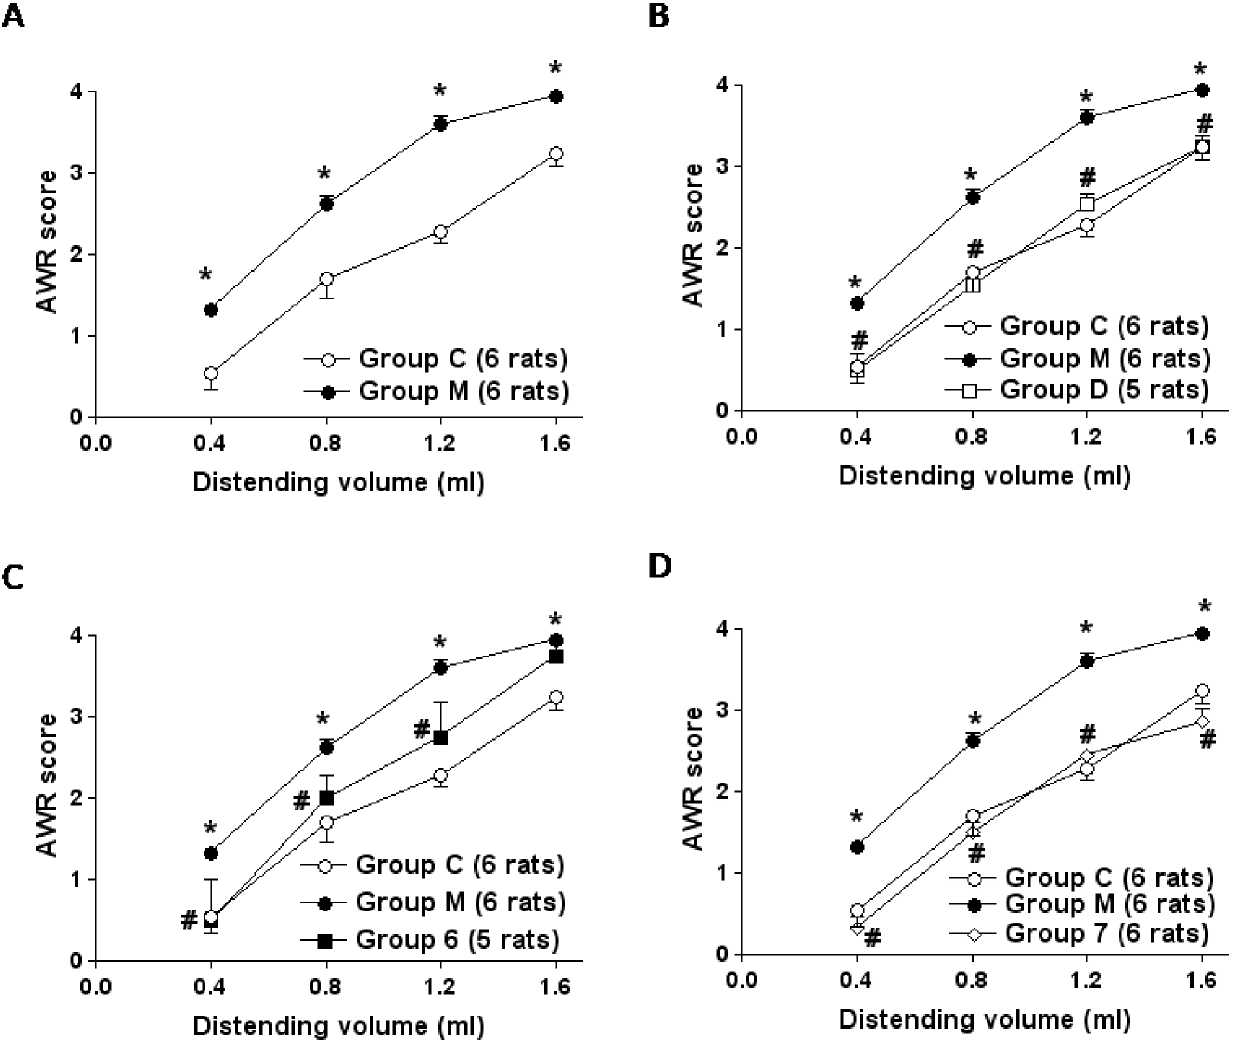
Figure 1. VSL # 3 reverses hypersensitivity induced by NMS. (A) Group C and Group M are the same in all comparison experiments. In healthy animals (Group C, 6 rats) CRD (0.4–1.6 ml water) elicited a volume-dependent increase of the AWR scores while caused allodynia and hyperalgesia in NMS animals (Group M, 6 rats). (B, D) VSL # 3 administered from day 3 to day 60 (Group D, 5 rats) and from day 45 to day 60 (Group 7, 6 rats) restored normal sensitivity. (C) Probiotic intervention from day 3 to day 15 (Group 6, 5 rats) was only partially effective in visceral sensitivity as hyperalgesia persisted. Statistical comparisons were performed by the Mann-Whitney test for unpaired data and by the Wilcoxon signed rank test for paired data when two group of data were analyzed, and by the ANOVA for non parametric data, Kruskal-Wallis followed by Dunns comparison of selected pairs of column, when more than two groups of data were analyzed. *p , 0.05 vs Group C; # p , 0.05 vs Group M.